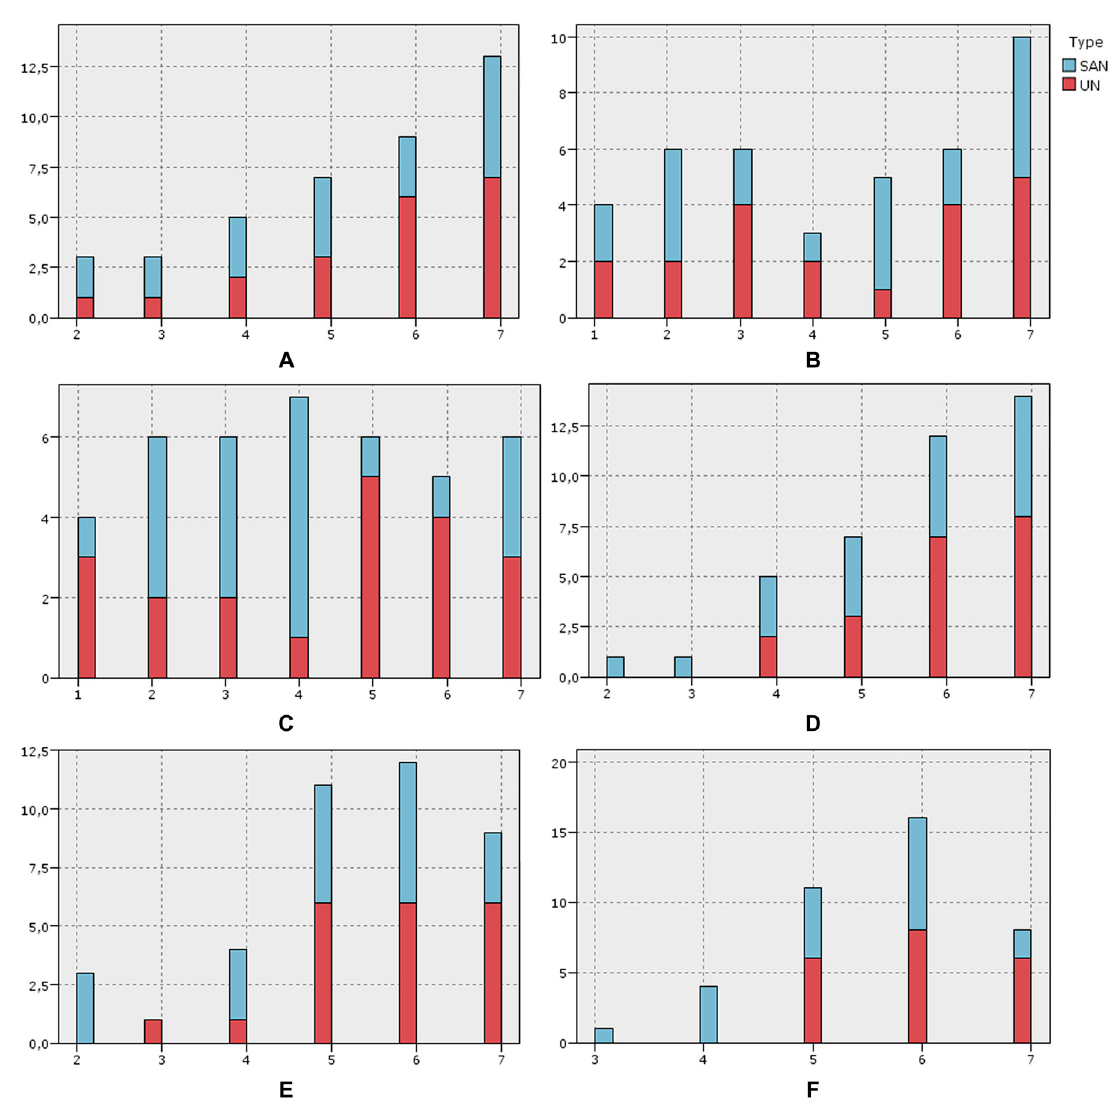
Figure A3. Communication with partner. UN = unassisted negotiation; SAN = smart assisted negotiation; A = I could react quickly and easily to my partner during the negotiation.; B = I could quickly and easily express my feelings during the negotiation.; C = I could quickly and easily understand my partner’s feelings during the negotiation.; D = I was able to express my views correctly during this negotiation.; E = I could understand the views of my partner correctly during this negotiation.; F = I convinced my partner to accept my offers.